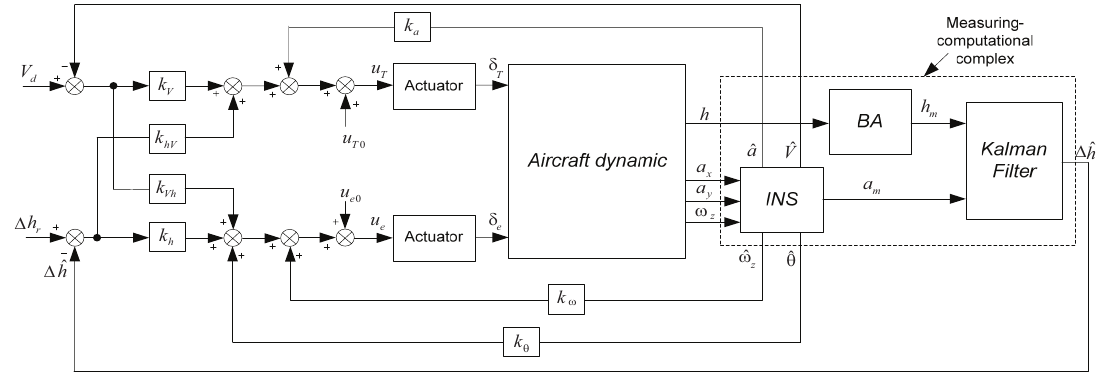
Figure 4. An altitude/speed hold autopilot